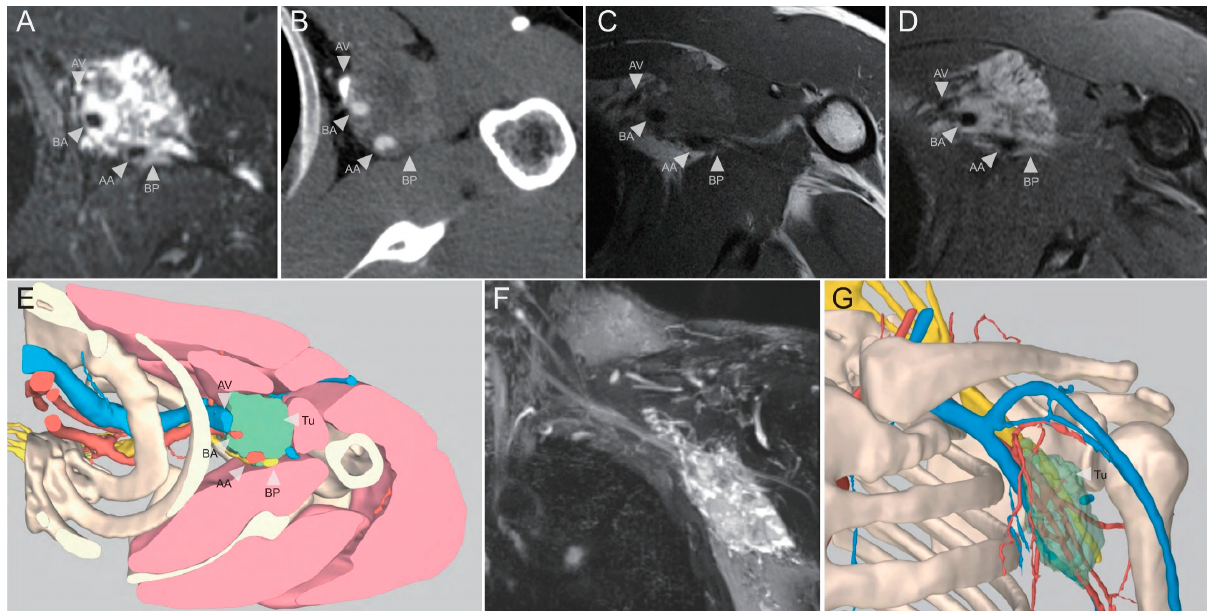
Figure 2. Classic images and their 3D reconstructions in a patient with axillary Ewing’s sarcoma. ( A ) MR hydrography image; ( B ) CT angiography image; ( C ) T1-weighted MRI; ( D ) T2-weighted MRI; ( E ) multimodality 3D reconstruction image with similar axial views as ( A – D ); ( F ) coronary view of